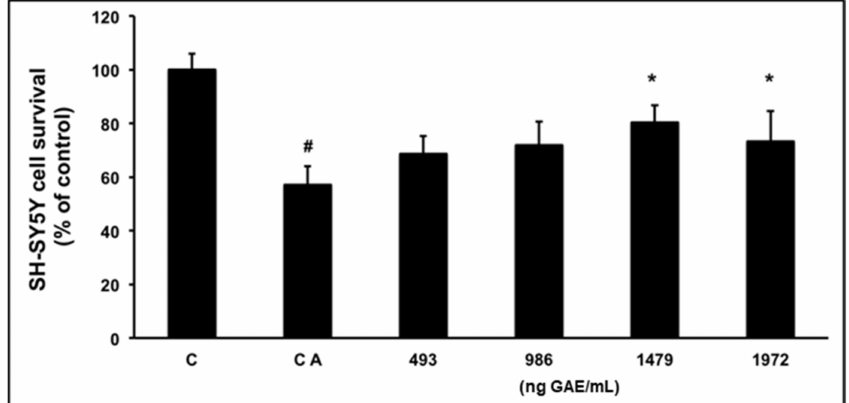
Figure 3. Protective effect of WP against 6-OHDA cytotoxicity in SH-SY5Y cells. SH-SY5Y cells were exposed to 6-OHDA (150 µ M) in the presence of increasing concentrations of WP (from 50 to 200 µ g/mL) corresponding to 494 to 1972 ng GAE/mL. Concentrations were expressed as ng gallic acid equivalent (GAE)/mL (9.86 ng GAE/ µ g WP). The control activated (CA) and control (C) bars mean that the cells were treated with and without 6-OHDA. The results are expressed as percentage of control and are represented by mean ± SD ( n = 3). # p < 0.05 compared to the (C) group and * p < 0.05 compared to the (CA) group.